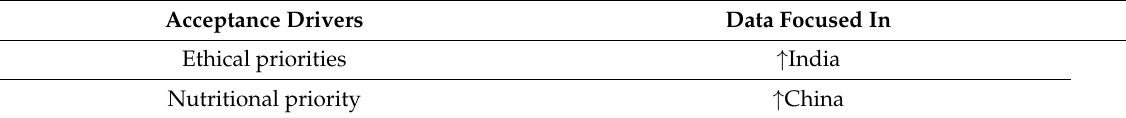
Table 1. Responsible drivers for the acceptance of cultured